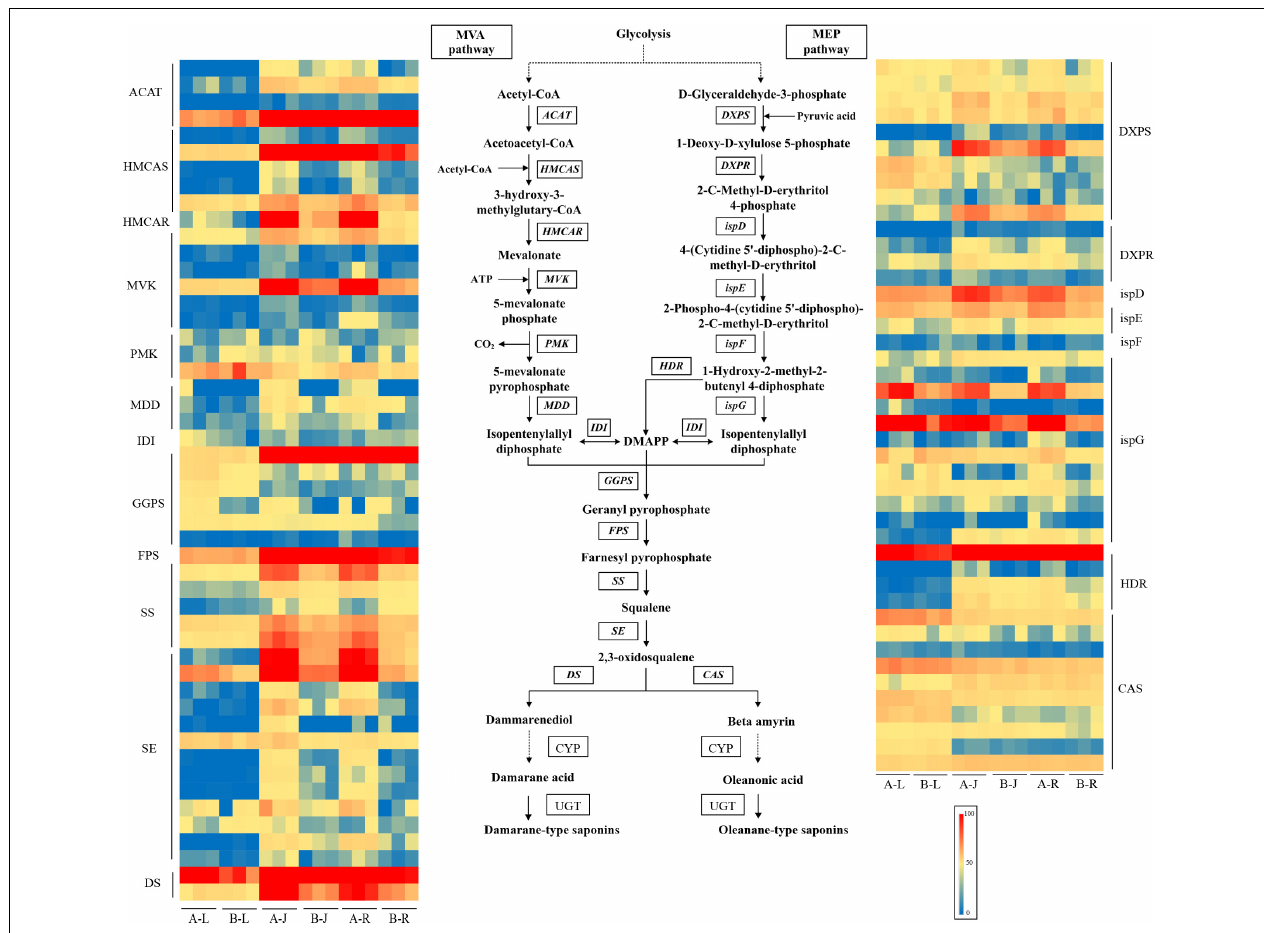
FIGURE 5 | Expression levels of mevalonic acid pathway transcripts involved in saponin biosynthesis in P.